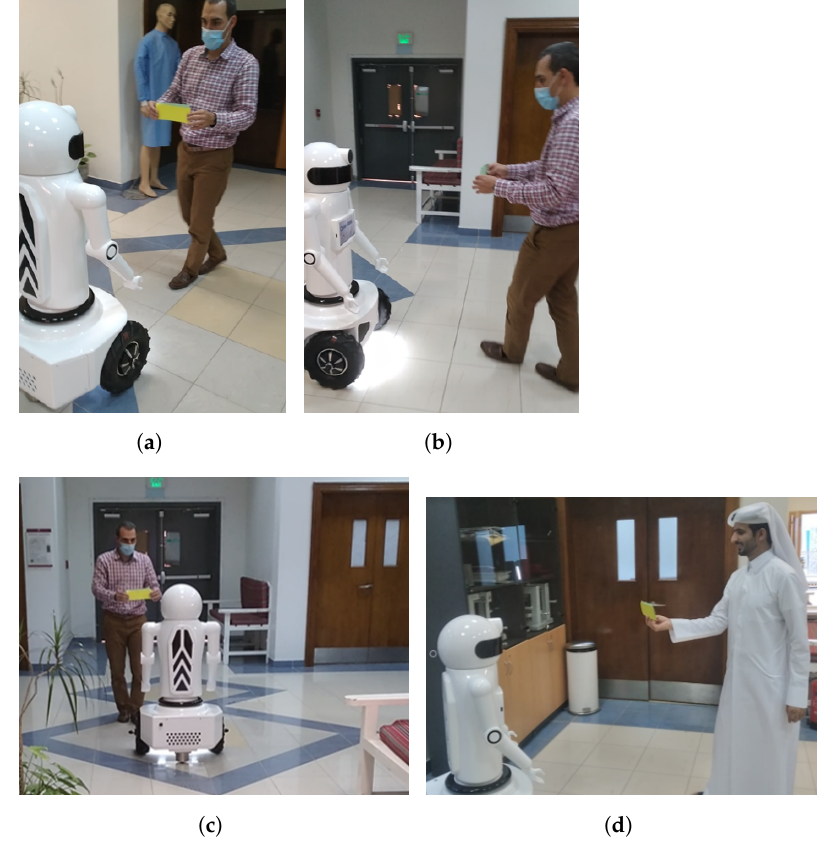
Figure 28. Marker label following scenes: ( a–d ) different light